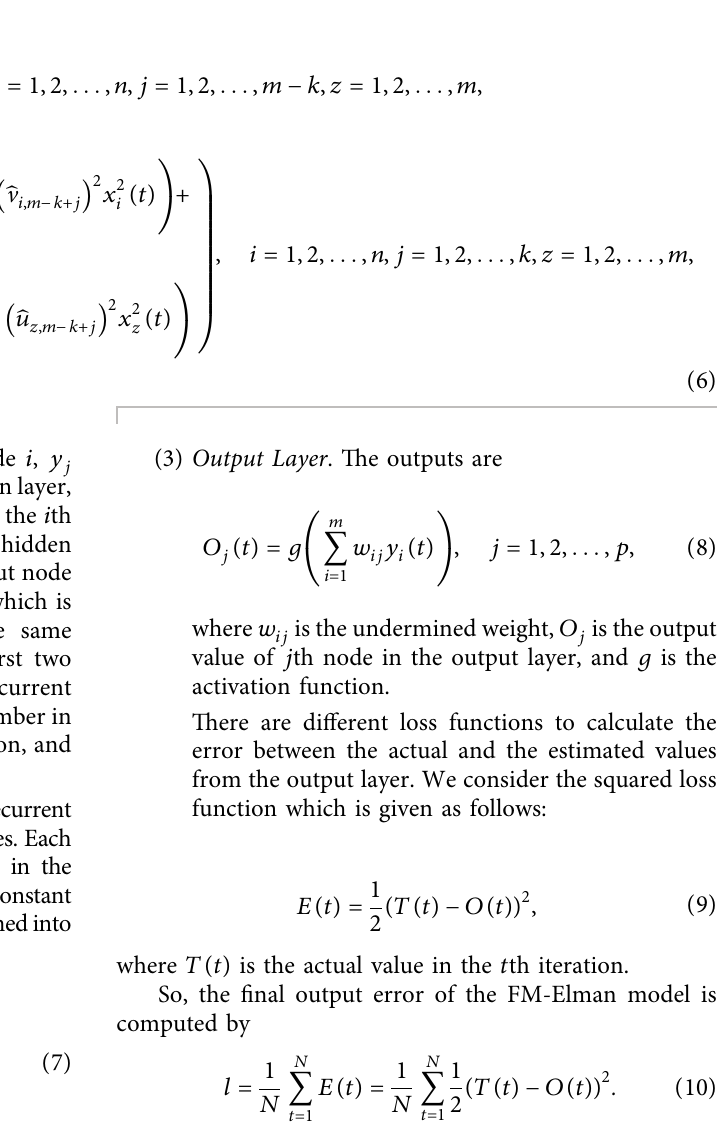
Figure 2: Structure of the Elman neural network with factorization